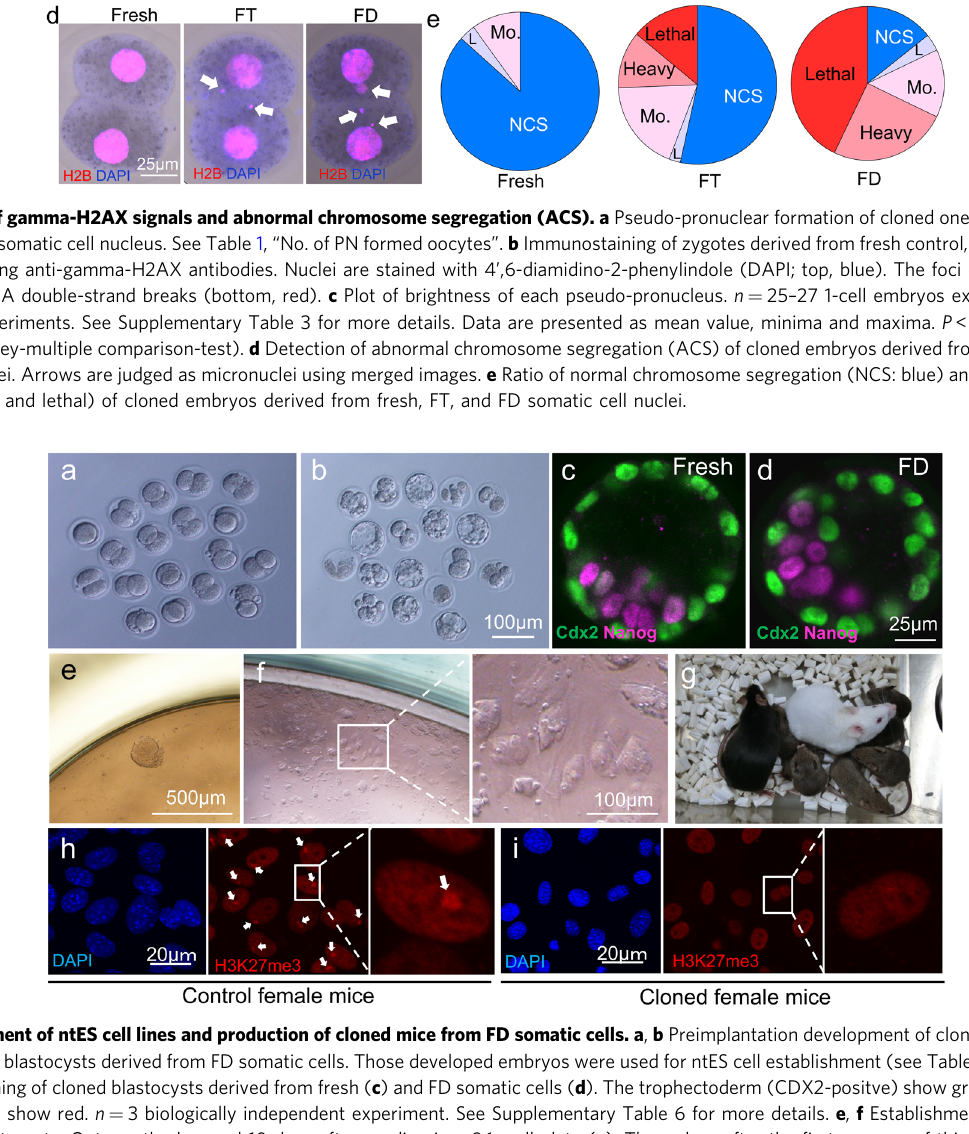
(Table 1). Although cloned morulae were generated from all examined mouse strains, only one cloned blastocyst was obtained from the BDF1 strain (0.1%). However, when epigallocatechin was used to generate FD somatic cells, the rate of formation of cloned blastocysts derived from BDF1 cumulus cells was sig- ni fi cantly improved (2.1%).